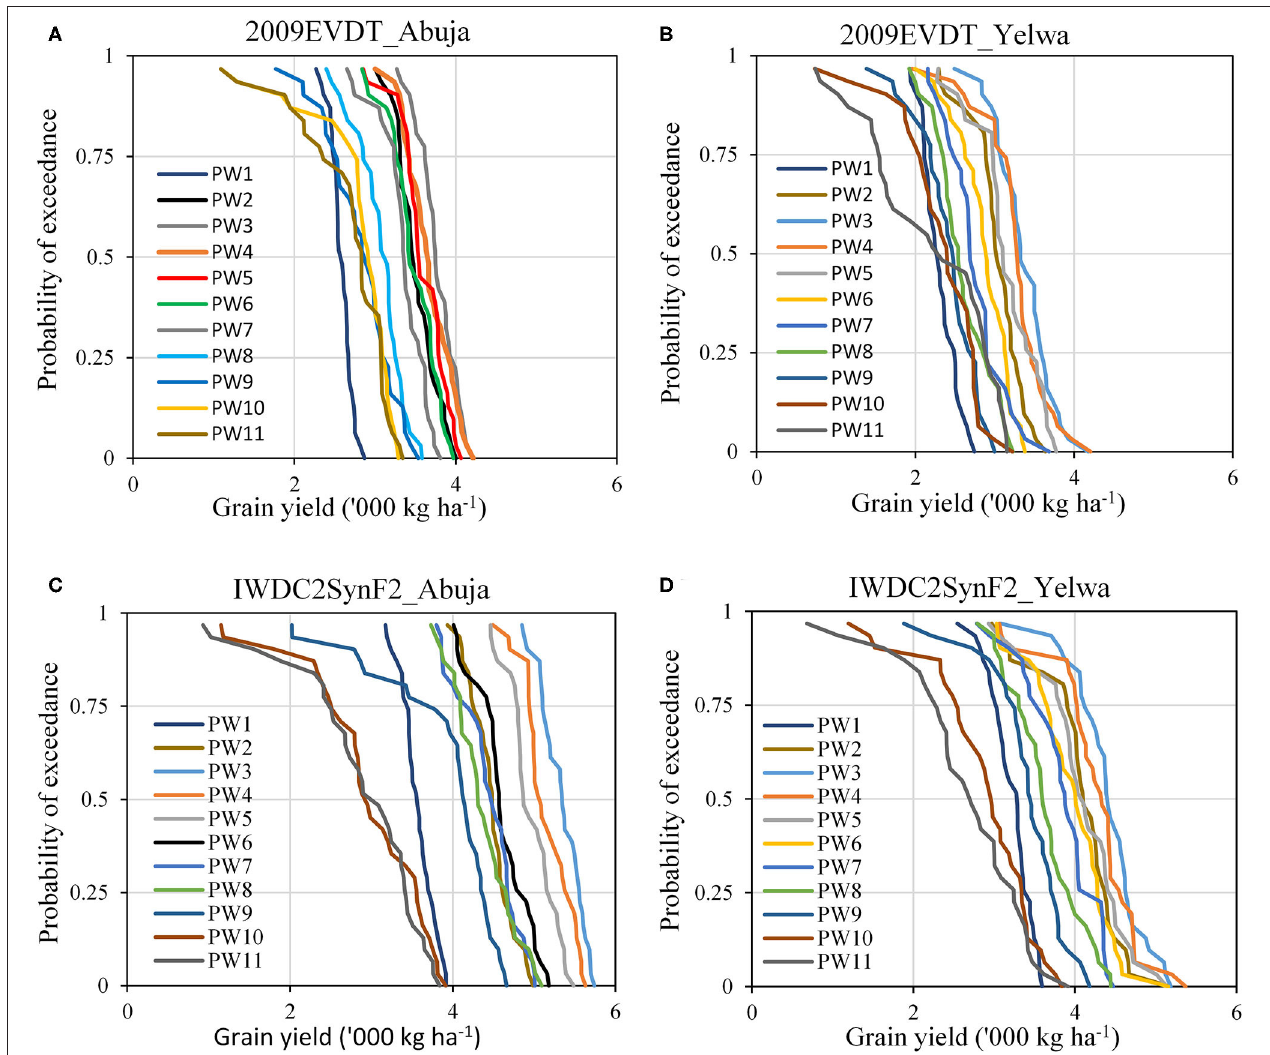
( Figure 5D ). These results suggest that the length of planting (June 15–July 19) at Zaria and 42 days (June 8–July 19) at Sabon- Gari for 2009EVDT. The best planting window for IWDC2SynF2 indicates PW3 (June 15)—PW7 (July 19) ∼ 35 days at